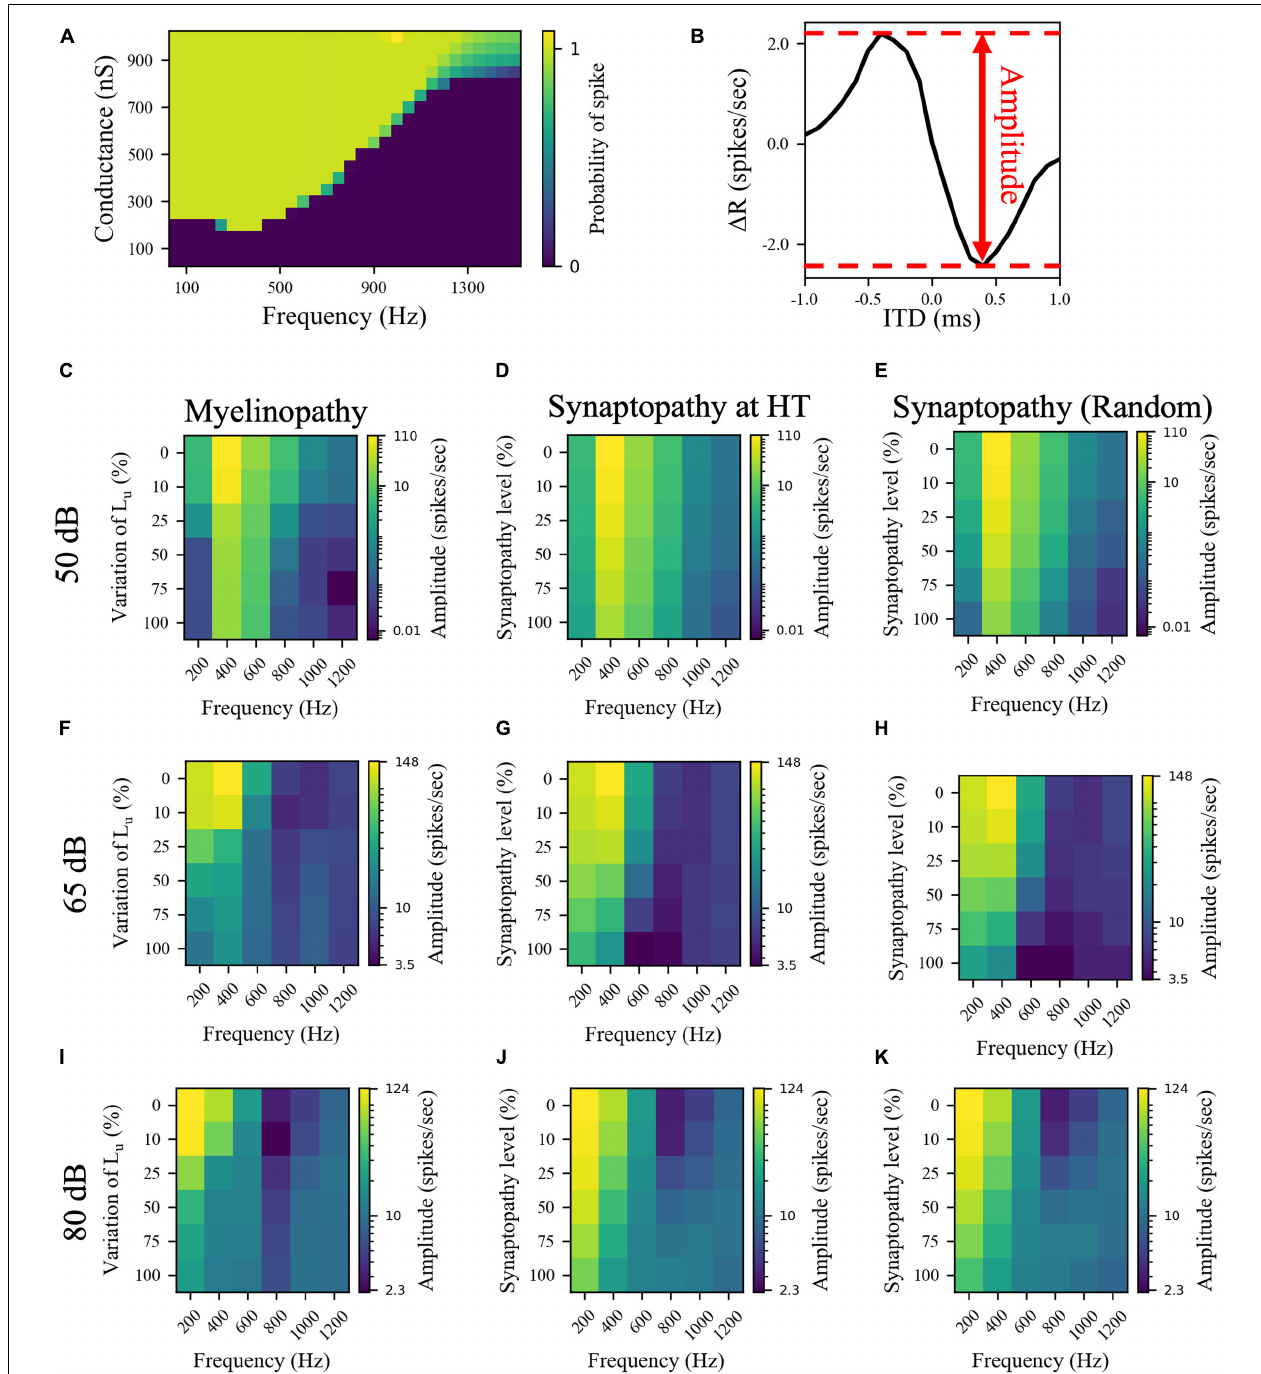
FIGURE 5 | The effects of different peripheral auditory disruption conditions on the activity of MSO cells were less pronounced at the sound frequencies where MSO cells show resonant responses. (A) Spike probability (color bar) of individual MSO cells with varying synaptic conductances (Y-axis) in response to different sound frequencies (X-axis). Results provide evidence of resonant behavior for sound frequencies of ∼ 300 Hz. (B) The amplitudes in panels (C–K) are the distance between the peak and the trough of (cid:49) R, which is the difference between the activities of left and right MSO cells for different ITDs. (C–K) The amplitudes of (cid:49) R in response to 50 dB (C–E) , 65 dB (F–H) , and 80 dB (I–K) sound stimuli at frequencies varying from 200 to 1,200 Hz in peripheral auditory disruption scenarios of various levels. In myelinopathy (C,F,I) , 0% variation of L u represents a circuit with a homogeneous population of SGNs with 10 µ m long L u and 100% variation of L u represents a circuit with a heterogeneous SGN population with 10 µ m ≤ L u ≤ 20 µ m. In both synaptopathy scenarios [HT (D,G,J) and random (E,H,K) ], 0% synaptopathy indicates all IHC-SGN synapses are intact. Synaptopathy level of 100% means all IHC-HT SGN synapses are deficient in HT synaptopathy, whereas the same number of synapses are randomly removed in random synaptopathy (1/3rd of all synapses).